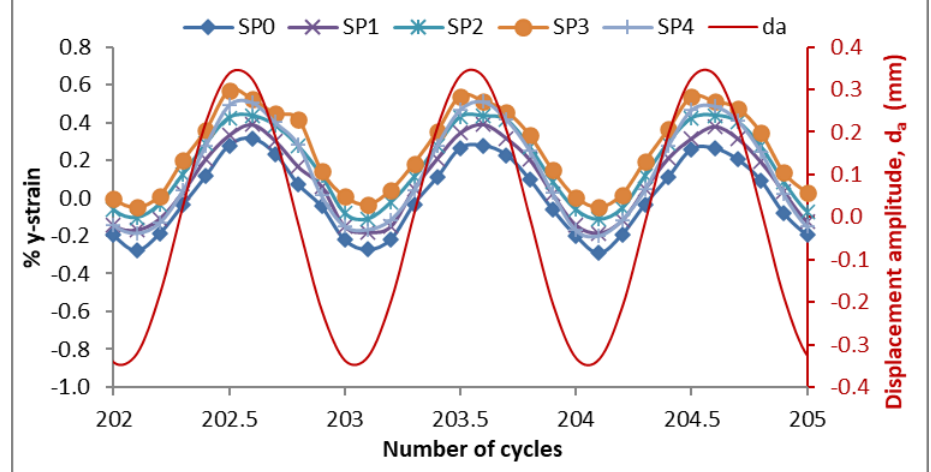
Figure 9. Longitudinal strain after 200 cycles; (d a = 0.35 mm).